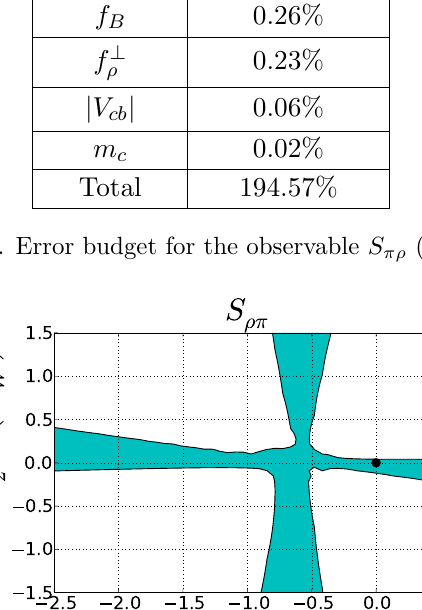
( M W ) allowed by the observable 2 ( M W ) is only weakly constrained and 1